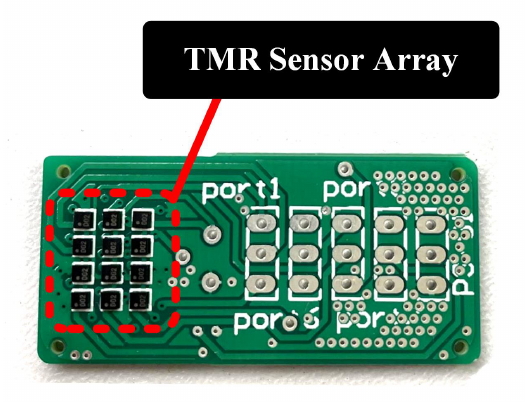
Figure 9. 4 × 3 implemented TMR sensor